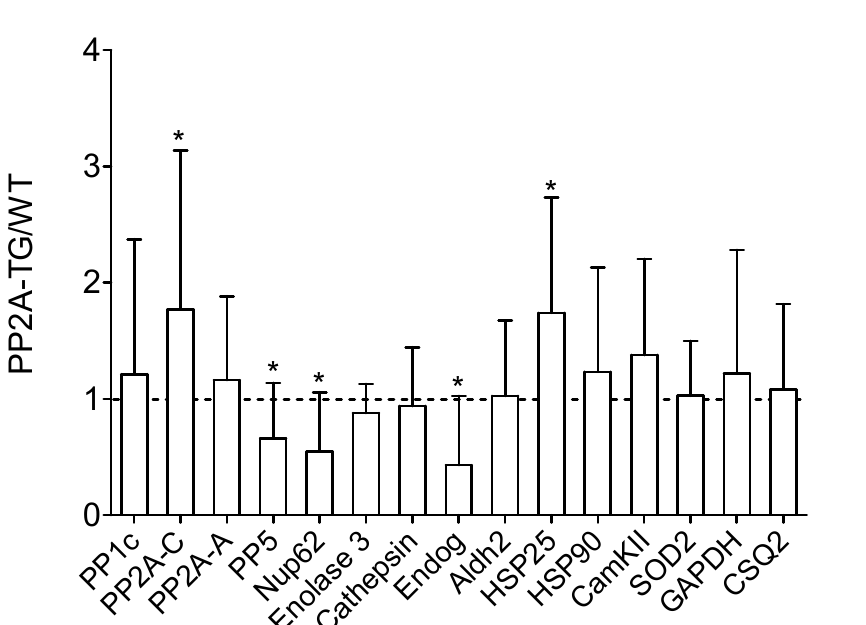
Figure 2. Basal cardiac protein expression. Basal cardiac protein expression of a selection of genes with various functions analyzed by Western blotting of wild type (WT) and PP2A overexpressing (PP2A-TG) mouse hearts. Original Western blots are shown in the supplementary Figures S5 and S6. Quantification data of Western blots are presented as ratio of the mean PP2A-TG signal divided by the mean WT signal ± SD. The abbreviations are: aldehyde dehydrogenase 2 (Aldh2), cardiac calsequestrin (CSQ2), Ca 2+ calmodulin kinase II (CamKII), endonuclease G (Endog), glycerin aldehyde phosphate dehydrogenase (GAPDH), heat shock proteins 25 and 90 (HSP25, HSP90), nucleoporin 62kDa (Nup62), catalytic alpha subunit of protein phosphatase 1 (PP1c), structural A-subunit and catalytic C-subunit of protein phosphatase 2A (PP2A-A, PP2A-C), protein phosphatase 5 (PP5), superoxide dismutase 2 (SOD2). * p < 0.05 vs. WT.